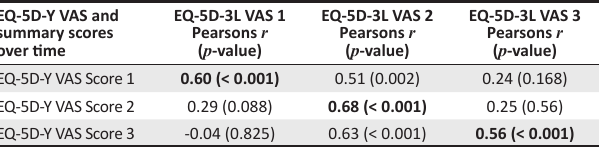
TABLE 1a: Correlation between the scores of the child and the caregiver over three